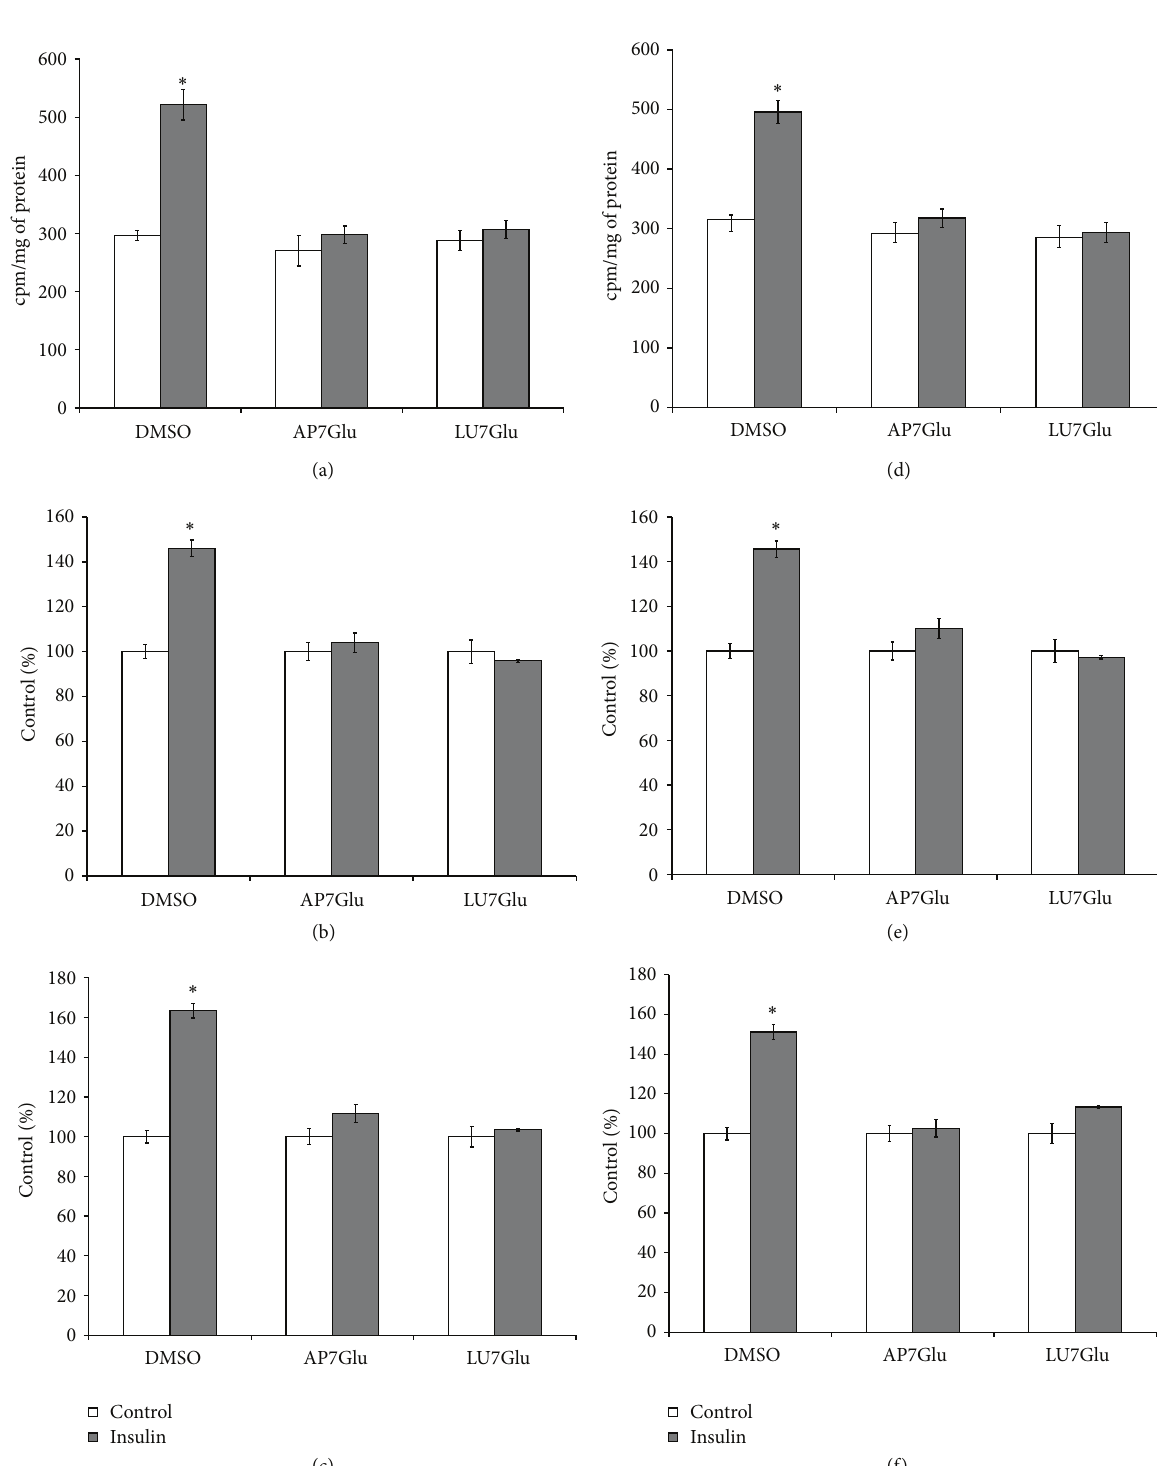
Figure 8: Effect of apigenin-7-O-glucoside and luteolin-7-O-glucoside on phospholipase D activity and glucose metabolism stimulation by insulinintheisolated hepatocytes. Apigenin-7-O-glucoside—AP7Glu, luteolin-7-O-glucoside—LU7Glu. Flavones added totheculturemedia prior to (a, b, c) and after (d, e, f) insulin as described in the Methods. (a, d) Phospholipase D activity, (b, e) uptake of 2-D-[ 3 H]glucose, (c, f) incorporation of D-[U 14 C]glucose into glycogen. ∗ 𝑝 < 0.05 , insulin versus